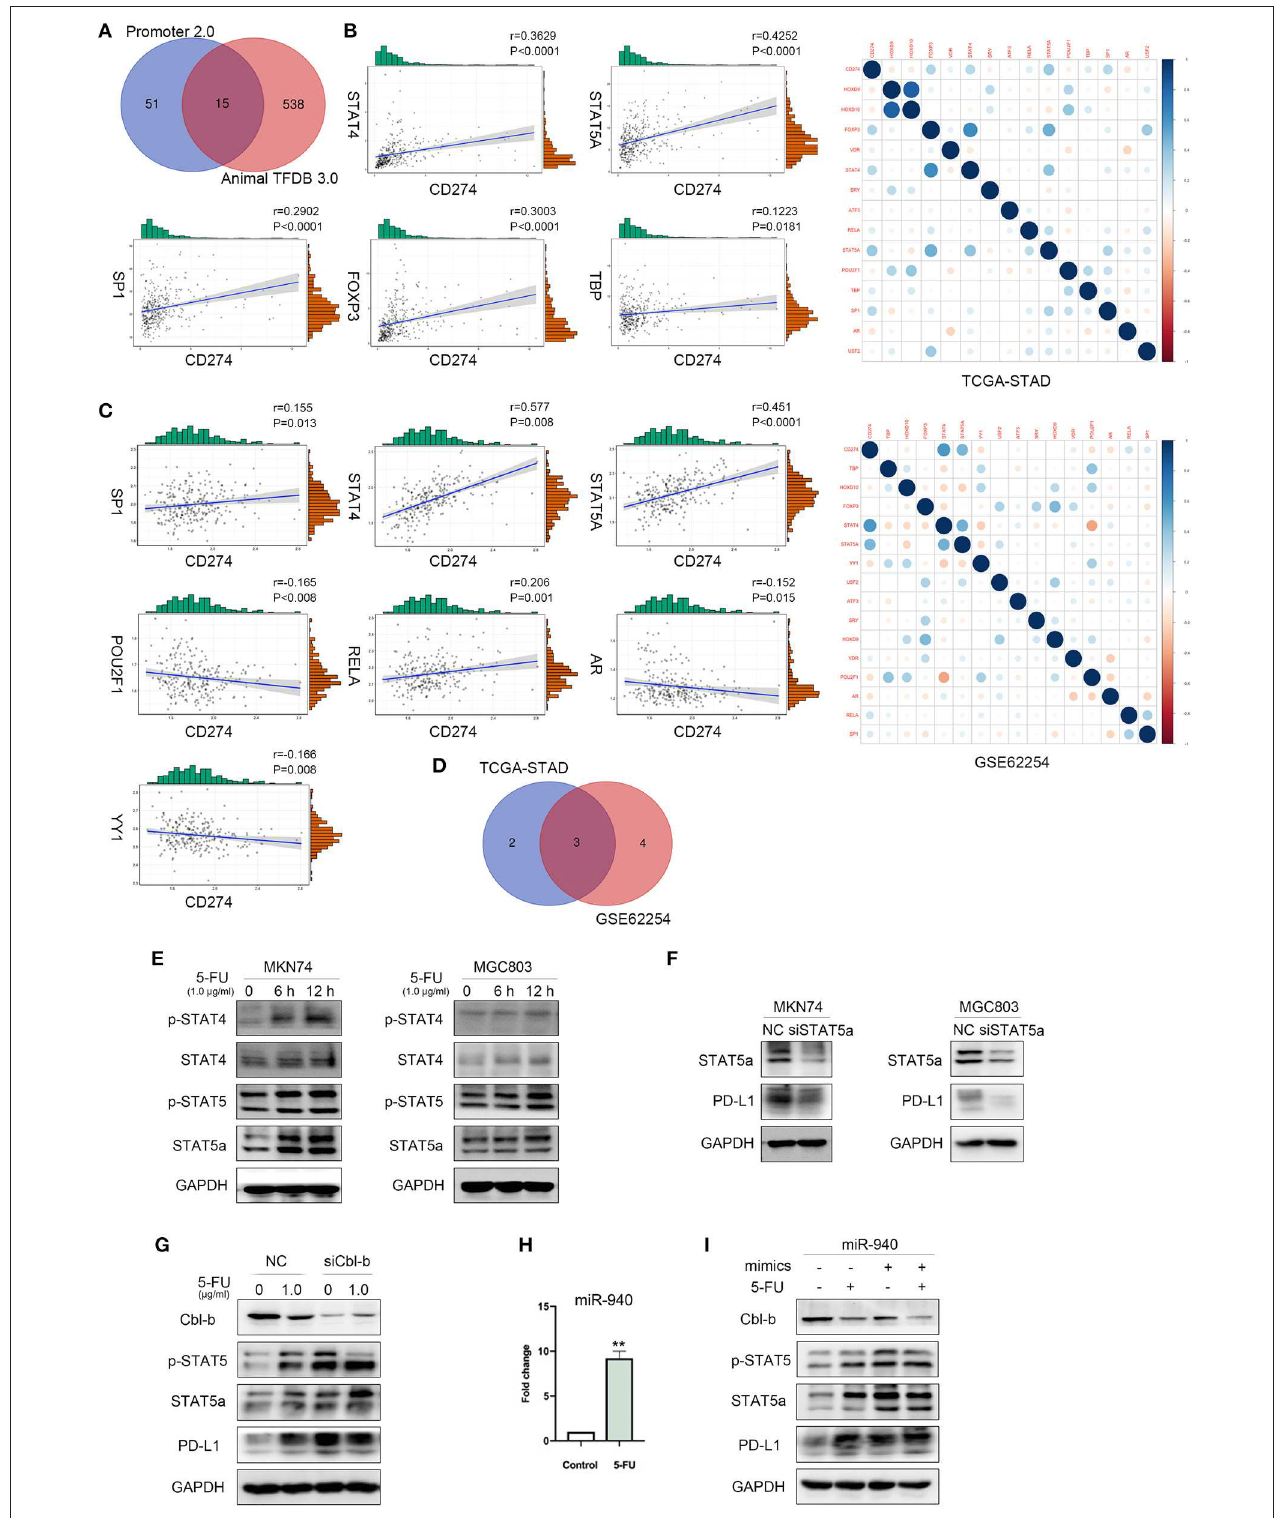
FIGURE 5 | MiR-940/Cbl-b/signal transducer and activator of transcription 5A (STAT5A) are involved in 5-fluorouracil (5-FU)-induced upregulation of programmed death-ligand 1 (PD-L1) in gastric cancer cells. (A) Online database Promoter 2.0 Prediction Server and Animal TFDB 3.0 predicted transcriptional factors of PD-L1.